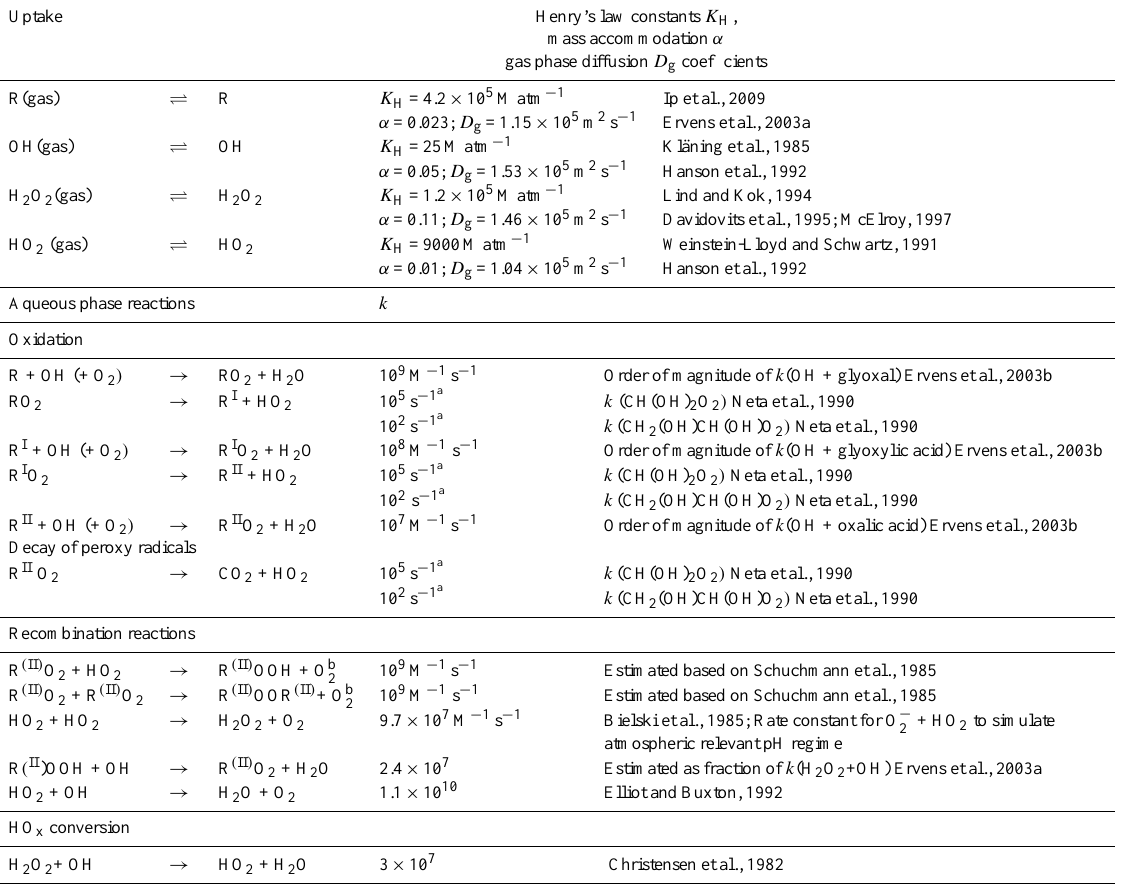
Table 4. Reaction scheme used to assess the fate of organic peroxy radicals (RO 2 ) in the aqueous phase of cloud droplets and aerosol particles (Fig. 6); R (II) O 2 , R (II) OOR (II) , R (II) OOH denote the sum of all organic peroxy radicals, organic peroxides and organic hydroperoxides,